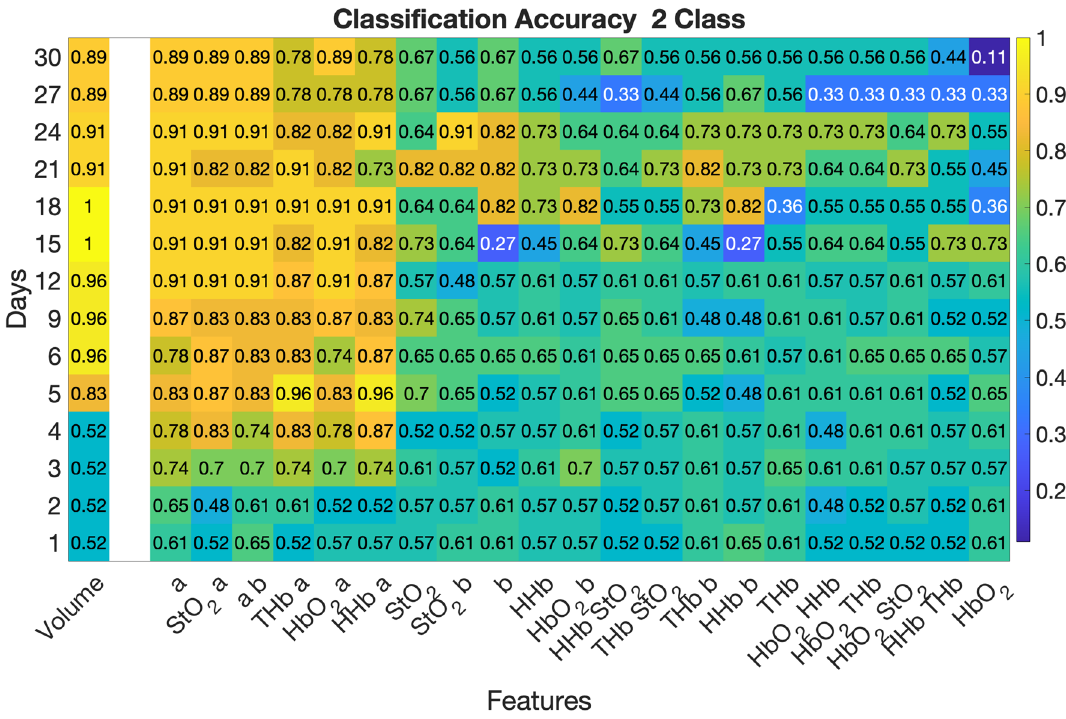
Figure 5. Long term classification accuracy feature selection for responders (CPA) versus resistant (CPA + Ab) cohorts. Linear discriminant analysis was conducted on the long-term cohort (through Day 30) for the treatment groups. The classification accuracy for each time point and feature is displayed in text and indicated by shading for each metric at each time point. SFDI derived parameters predicted earlier ability to discriminate responders versus resistance mice compared to tumor volume.